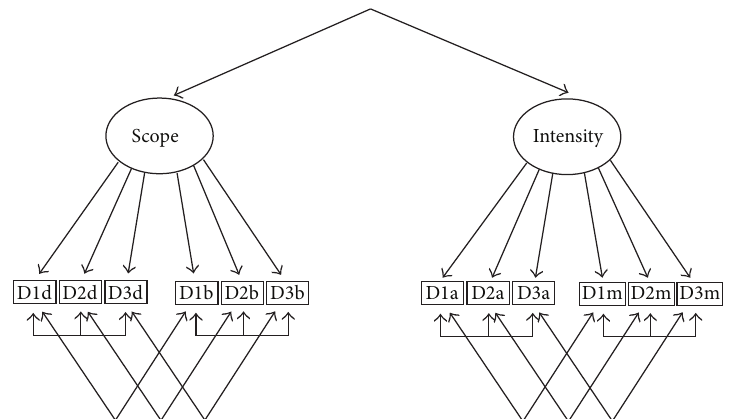
Figure 2: Model (d): the factor model that fits PDM data where D1d = decision 1 depth; D2d = decision 2 depth; D3d = decision 3 depth; D1b = decision 1 breadth; D2b = decision 2 breadth; D3b = decision 3 breadth; D1a = decision 1 activities; D2a = decision 2 activities; D3a = decision 3 activities; D1m = decision 1 mechanisms; D2m = decision 2 mechanisms; D3m = decision 3